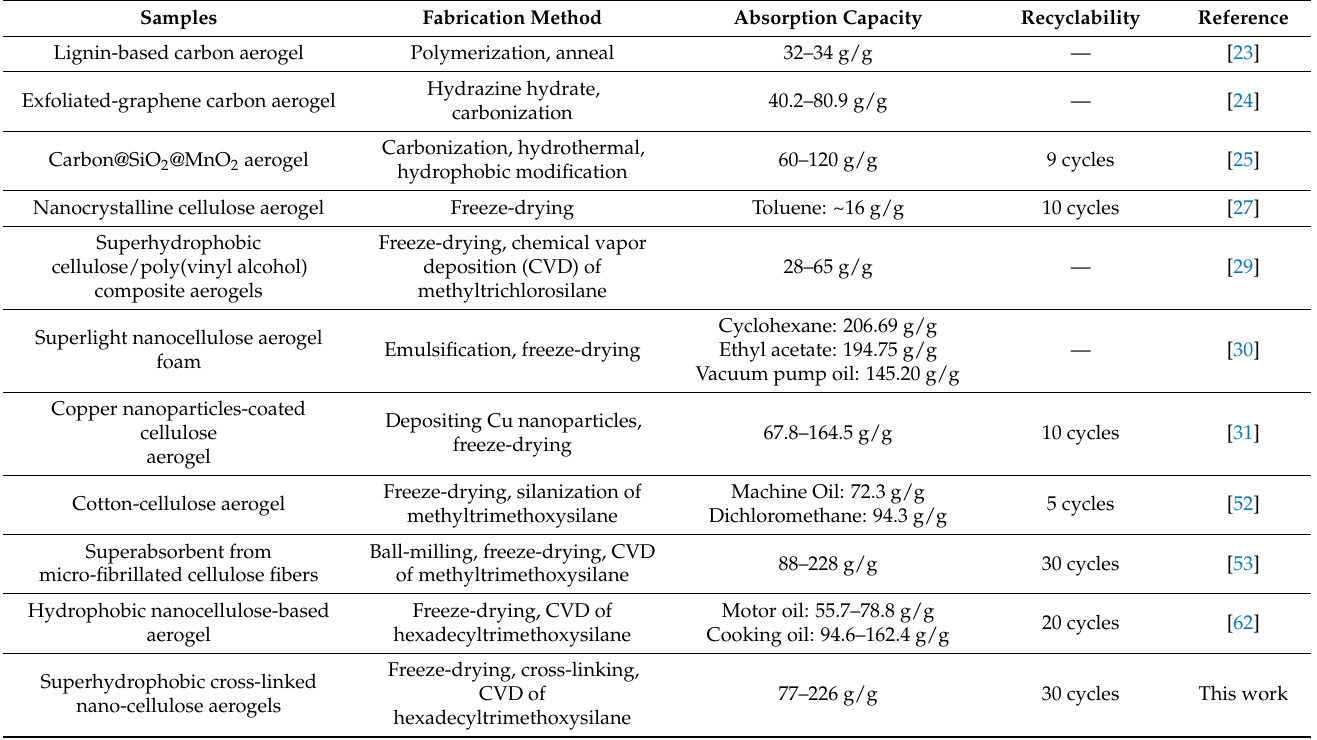
Figure 7. ( a ) Adsorption capacities of Si-CNF/BTCA aerogel for various organic liquids. ( b ) The correlation of the adsorption capacity of the Si-CNF/BTCA and the density of adsorbed oil and organic solvents. ( c ) Recyclability of Si-CNF/BTCA aerogel for the adsorption of chloroform within 30 cycles. Table 2. Comparison of the fabrication methods and the absorption performances of the different superhydrophobic aerogels.